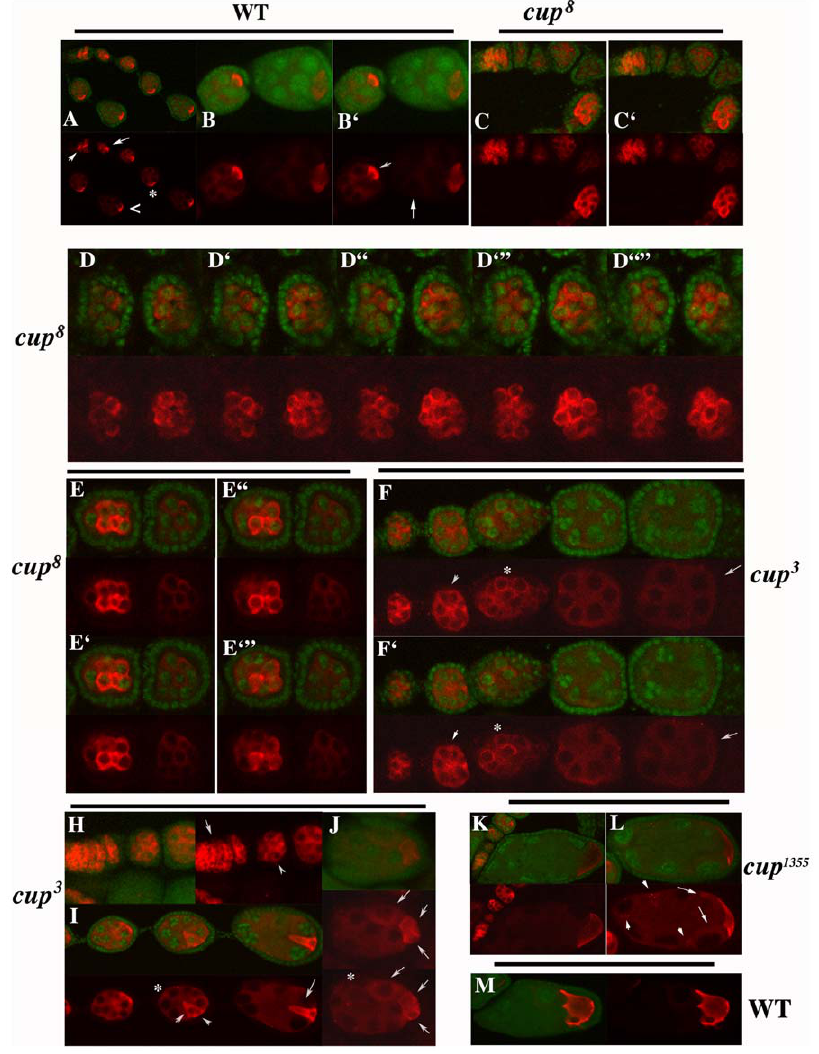
Figure 4. Orb is misexpressed in cup ovaries. Green: Nucleic acids. Red: Orb. Panels A–B 9 : In wild type, Orb is first expressed during the formation of the 16-cell cyst (arrowhead in A) and though it is present in most cells in the cyst, it is greatly enriched in the presumptive oocyte. The localization pattern is refined during early pre-vitellogenic stages (arrow in A); Orb becomes concentrated at the posterior of the oocyte ( . and * in A, arrowhead in B 9 ), while only low levels of protein are detected in the nurse cells closest to the oocyte (arrow in B 9 ). Panels B and B 9 : successive confocal sections through the same two egg chambers. Note that there are high levels of Orb protein in all of the germ cells in these two chambers. Panels C, D and E: Chambers from cup 8 ovaries. In each case several focal planes are shown and are designated as ‘. In cup 8 16-cell cysts Orb is present at high levels in most of the cells (C, C 9 ). Unlike wild type the Orb localization pattern does not refine during the early pre-vitellogenic stages and high levels of Orb persist in most of the cells in the chamber. The distribution of Orb in two ‘‘early’’ cup 8 chambers is shown in panels D-D 00 . Note that many cells in these two chambers have high levels of Orb protein. Two other cup 8 chambers are shown in panels E-E 0 . In the chamber on the left Orb is clearly concentrated in a subset of the cells. In the chamber on the right the level of Orb protein is low. A marked reduction in the level of Orb protein is typically observed in older cup 8 chambers. Panels F–J show the pattern of Orb accumulation in cup 3 chambers. Like cup 8 , chambers that have high levels of Orb in most germ cells are often observed in the cup 3 mutant (arrowhead in F, F 9 and H). Orb also accumulates in rings around the nurse cell nuclei (* in F, F 9 ) or in clumps in the nurse cell cytoplasm (* in I and J). In some cup 3 chambers Orb concentrates in several cells near the posterior (arrow heads in I, arrows in J) while in other chambers the oocyte has an abnormal elongated shape (arrow in I). Panels K and L show cup 1355 chambers while panel M shows a wild stage 7–8 chamber. Orb accumulation during the early stages of oogenesis usually appears normal in cup 1355 (panel K); however in older chambers, high than normal levels Orb protein are seen in the nurse cells (arrows in L) and there are often clumps of Orb protein (arrowheads in L). In older wild type chambers (panel M) Orb is localized to the oocyte cortex, while there is little Orb protein in the nurse